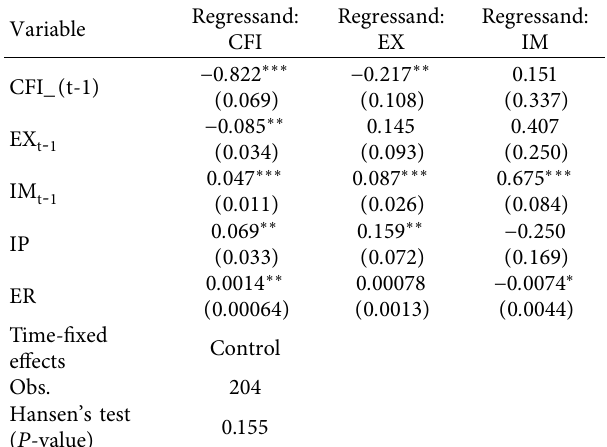
Table 3: Panel Unit Root Test Results. Variables